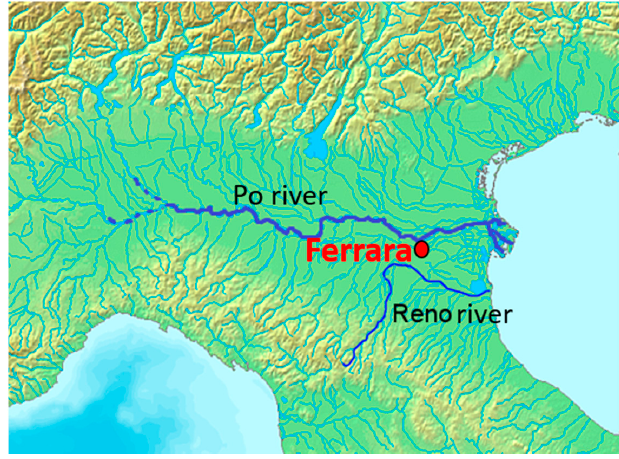
Figure 6. Schematic map of the flow related to the Po river and the Reno river with respect to the city of Ferrara (in red).